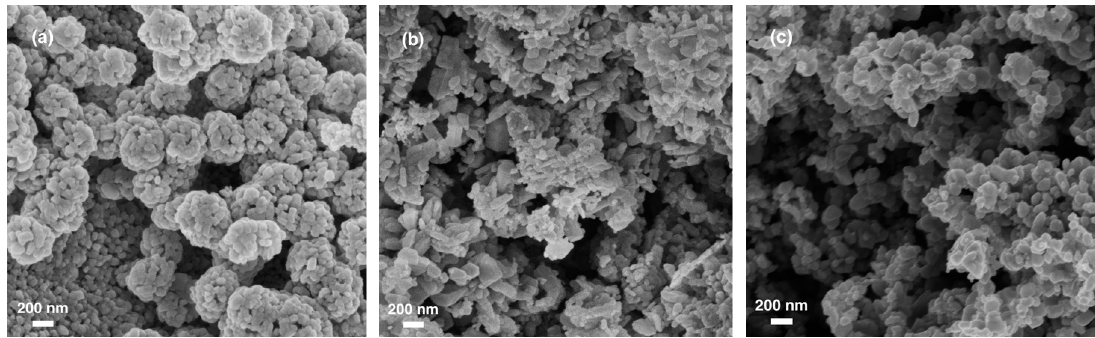
Figure 3. SEM images: ( a ) ZnO, ( b ) ZnO:Cu 5% and ( c ) ZnO:Co 5% thin films.